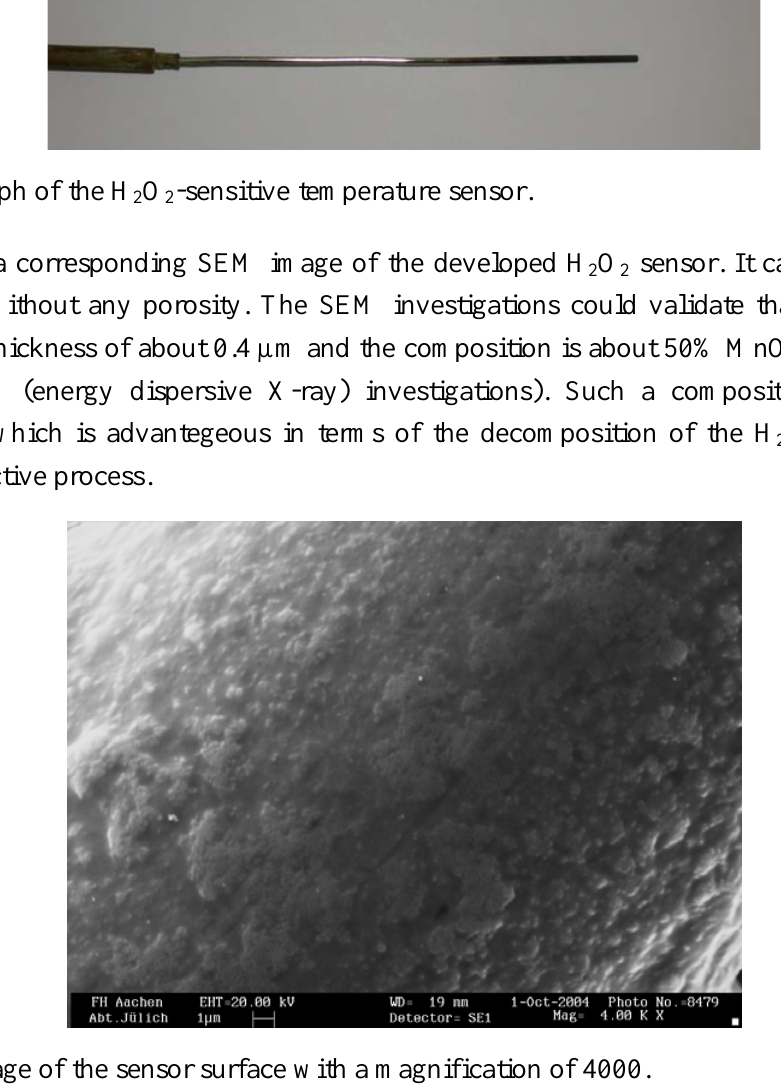
Figure 4. Photograph of the H